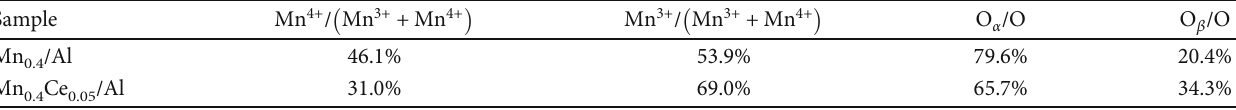
Ce /Al catalyst. 0.4 0.05 /Al and Mn Ce /Al. 0.4 0.4 0.05